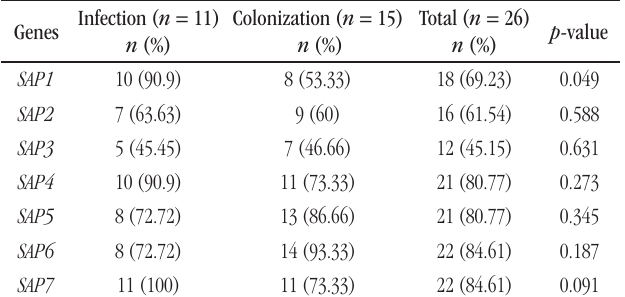
taBLE 2 − Frequency of SAP1-7 genes in C. albicans isolated from vulvovaginal infection and colonization